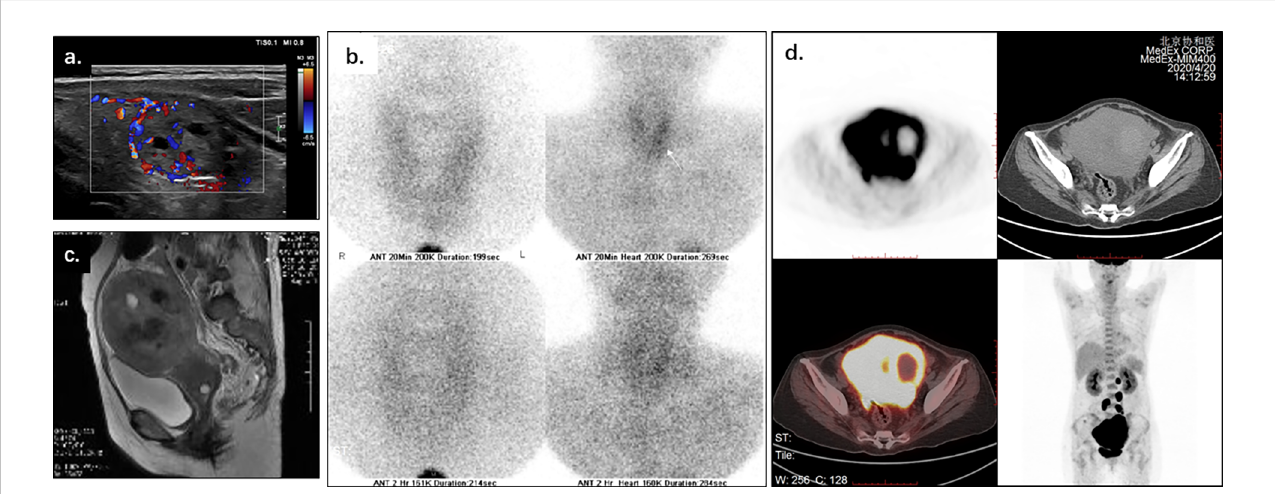
FIGURE 1 Thyroid ultrasonography, 99m Tc-MIBG, pelvic MRI, and PET-CT of a 56-year-old woman with life-threatening hypercalcemia. Thyroid ultrasonography (A) and 99m Tc-MIBG (B) showed a nodule inferior the left thyroid lobe, which may origin from parathyroid. Pelvic MRI (C) showed the uterus enlarged, with disrupted junctional zone, thickened myometrium, and abnormal signals in the uterine cavity. PET-CT (D) showed the irregularly enlarged uterus with increased SUV value (max to 15.7), as while multiple enlarged lymph nodes along the uterus, abdominal aorta, and bilateral common iliac arteries (SUVmax